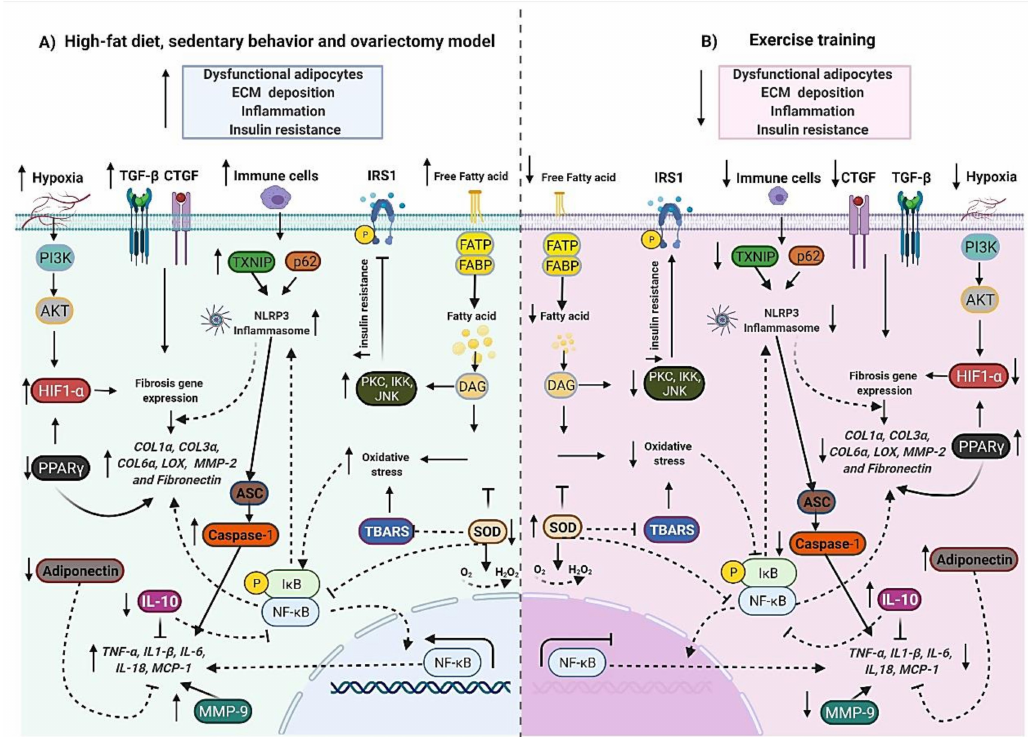
Figure 5. The molecular landscape of adipose tissue extracellular matrix remodeling in response to di- etary patterns and exercise training. ( A ) The high-fat diet, sedentary behavior, and ovariectomy model induces dysfunctional adipocytes ( ↑ lipid accumulation), ECM deposition ( ↑ pro-fibrotic gene expres- sion), inflammation ( ↑ NLRP3 inflammasome, NF- κ B, pro-inflammatory cytokines, macrophage and MMP-9), oxidative stress ( ↑ ROS production and hiobarbituric acid reactive substances (TBARS)), and insulin resistance ( ↑ insulin and blood glucose levels). ( B ) Exercise attenuates dysfunctional adipocytes ( ↓ lipid accumulation), ECM deposition ( ↓ pro-fibrotic gene expression), inflammation ( ↓ NLRP3 inflammasome, NF- κ B, pro-inflammatory cytokines, macrophage, and MMP-9), oxidative stress ( ↓ ROS production and hiobarbituric acid reactive substances (TBARS)), ↑ antioxidant activity (superoxide dismutase (SOD)) and insulin resistance ( ↓ insulin and blood glucose levels). Biorender web-based software was used to create the figure (License Number